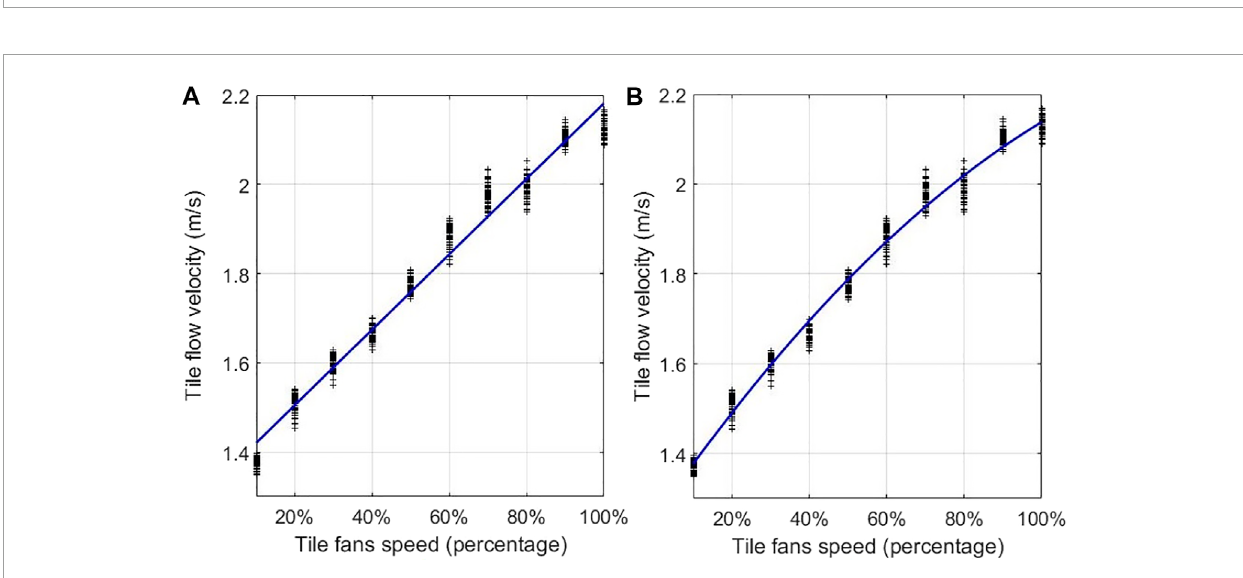
FIGURE 13 Tile air flow velocity is a function of the fan speed up, which is expressed by the polynomial with first order (A) and second order (B) .